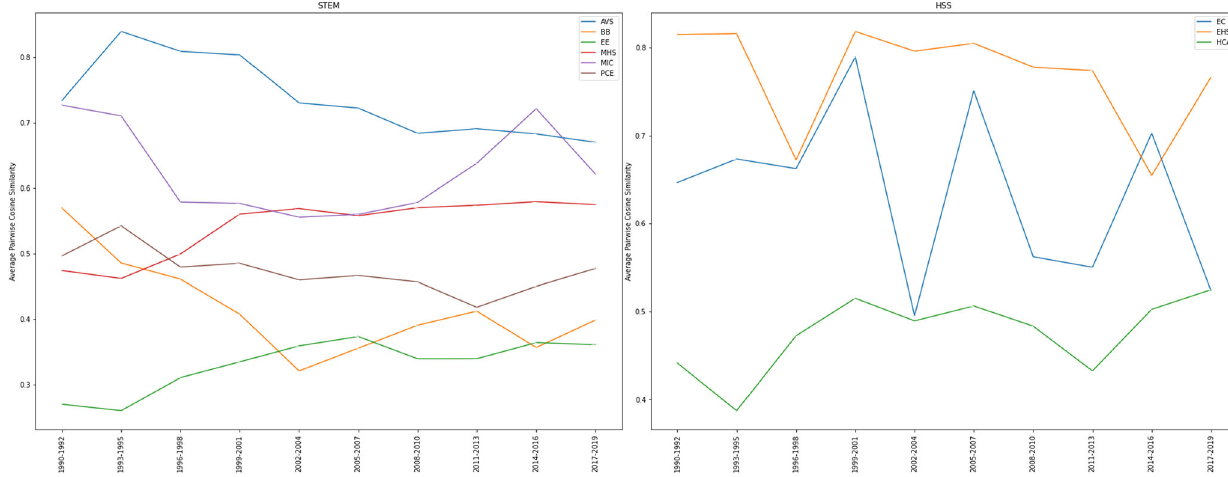
Fig. 1 Average cosine similarity between FoR embeddings over time. The left panel shows clusters of STEM disciplines. ‘ AVS ’ stands for Agricultural and Veterinary sciences, ‘ BB ’ stands for Biological and Biotechnological Sciences, ‘ EE ’ stands for Engineering and Environmental Sciences, ‘ MHS ’ stands for Medical and Health Sciences, ‘ MIC ’ stands for Mathematical, Information and Computing Sciences, and ‘ PCE ’ stands for Physical, Chemical and Earth Sciences. The right panel shows clusters of HSS disciplines. ‘ EC ’ stands for Economics and Commerce, ‘ EHS ’ stands for Education and Human Society, and ‘ HCA ’ stands for Humanities and Creative Arts (see Supplementary Table